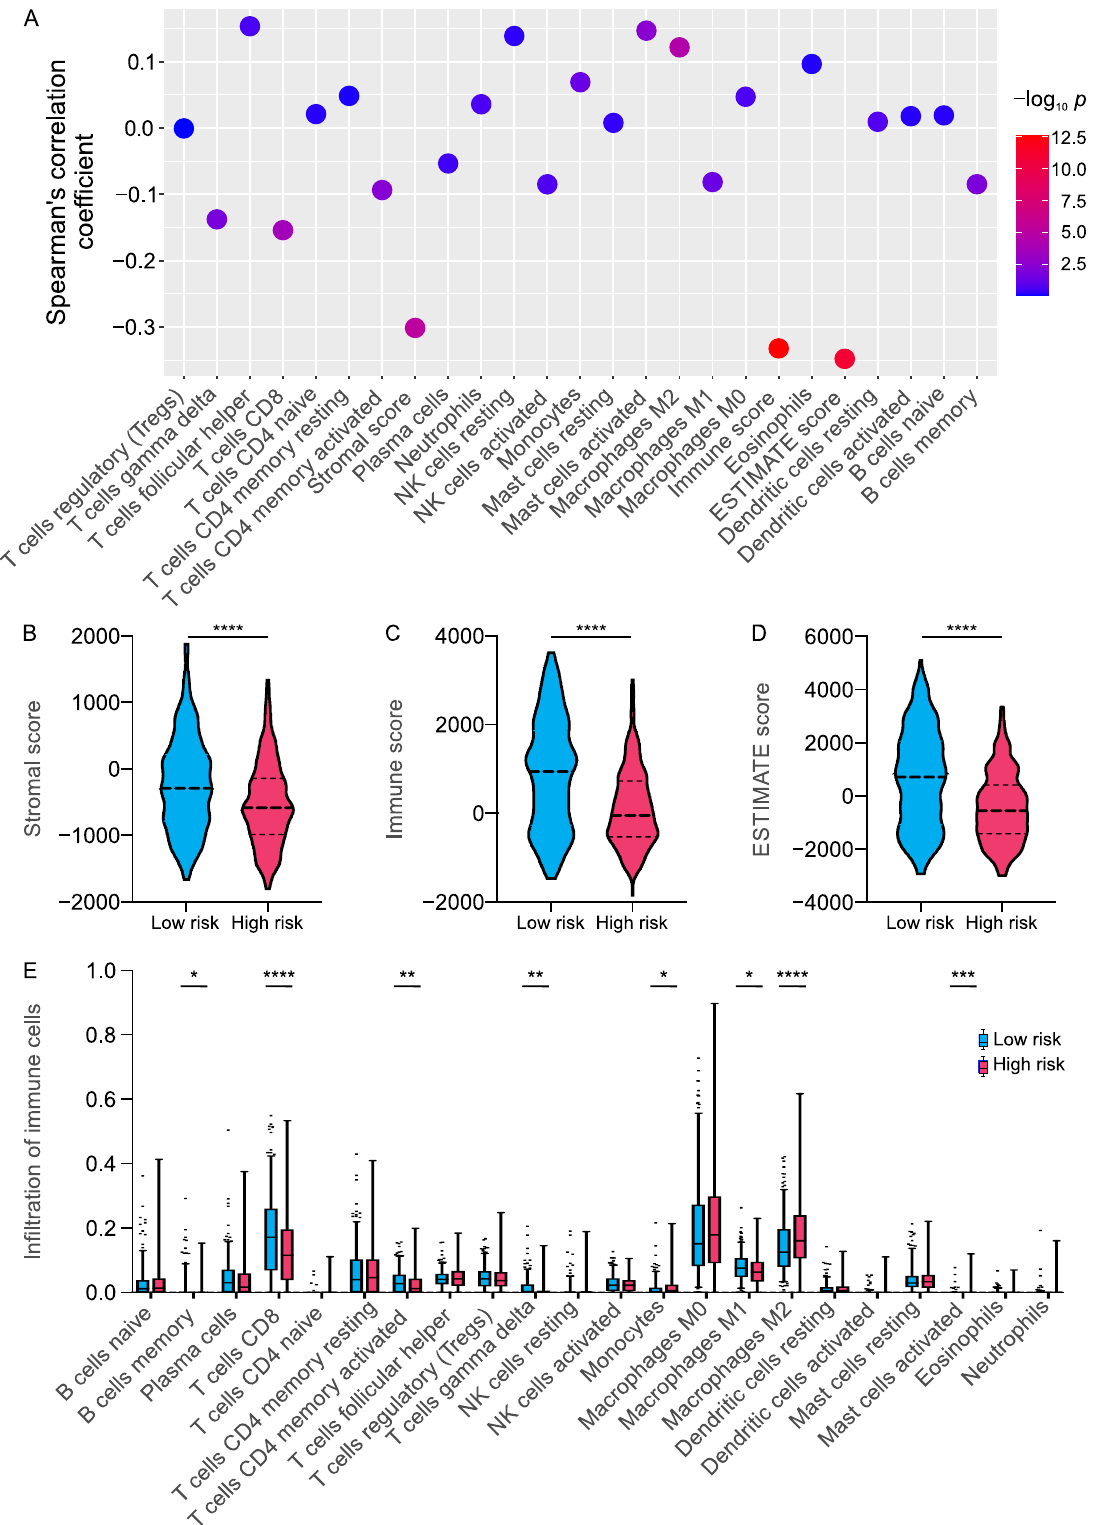
Figure 6. The differences in immune infiltration between high- and low-risk CM patients: ( A ) Correlation analyses. The color of the dot indicates the level of significance (-log 10 p ). ( B – E ) Violin plot depicted the differences of the stromal score, immune score, ESTIMATE score and the infiltration of 22 immune cells between patients in high- and low-risk groups. **** p < 0.0001, *** p < 0.001, ** p < 0.01, * p < 0.05.